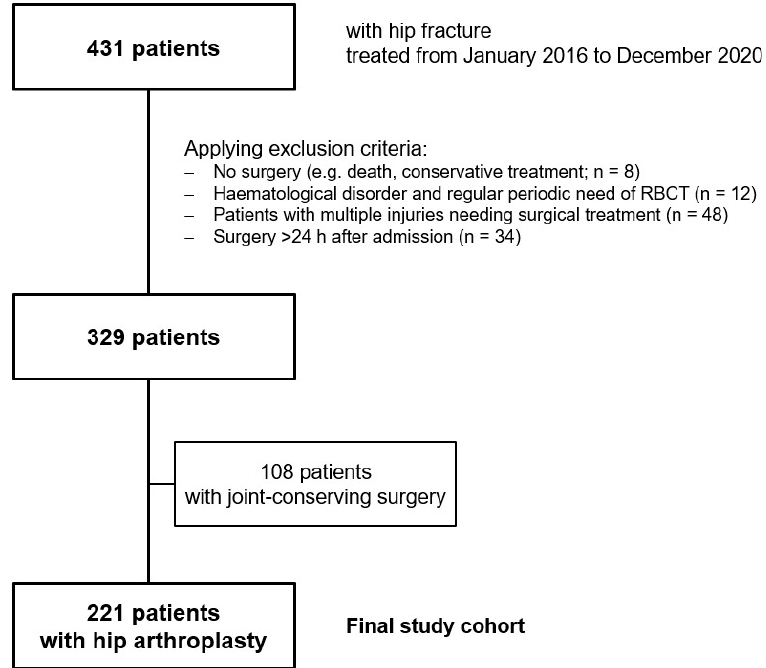
Figure 1. Study flow chart: a retrospective chart review.